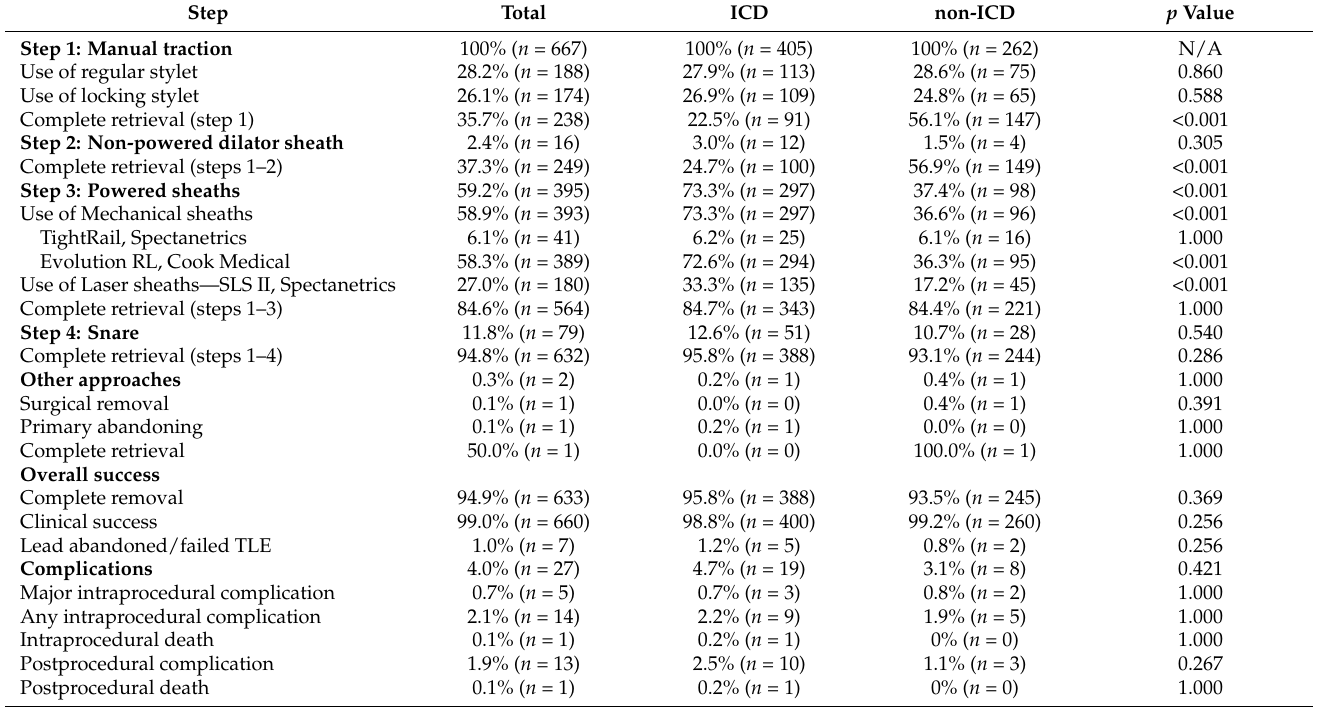
Table 3. Extraction techniques used for successful lead